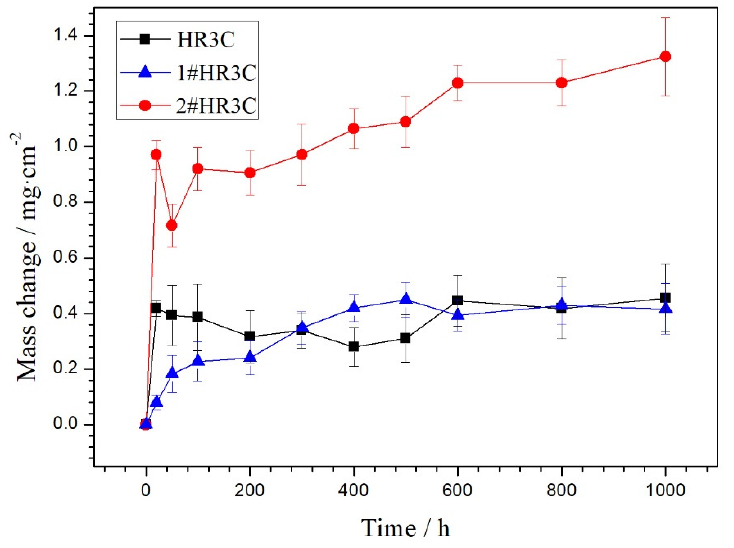
Figure 2. Steam oxidation kinetics of the three groups of HR3C alloys at 650 °C for 1000 h.